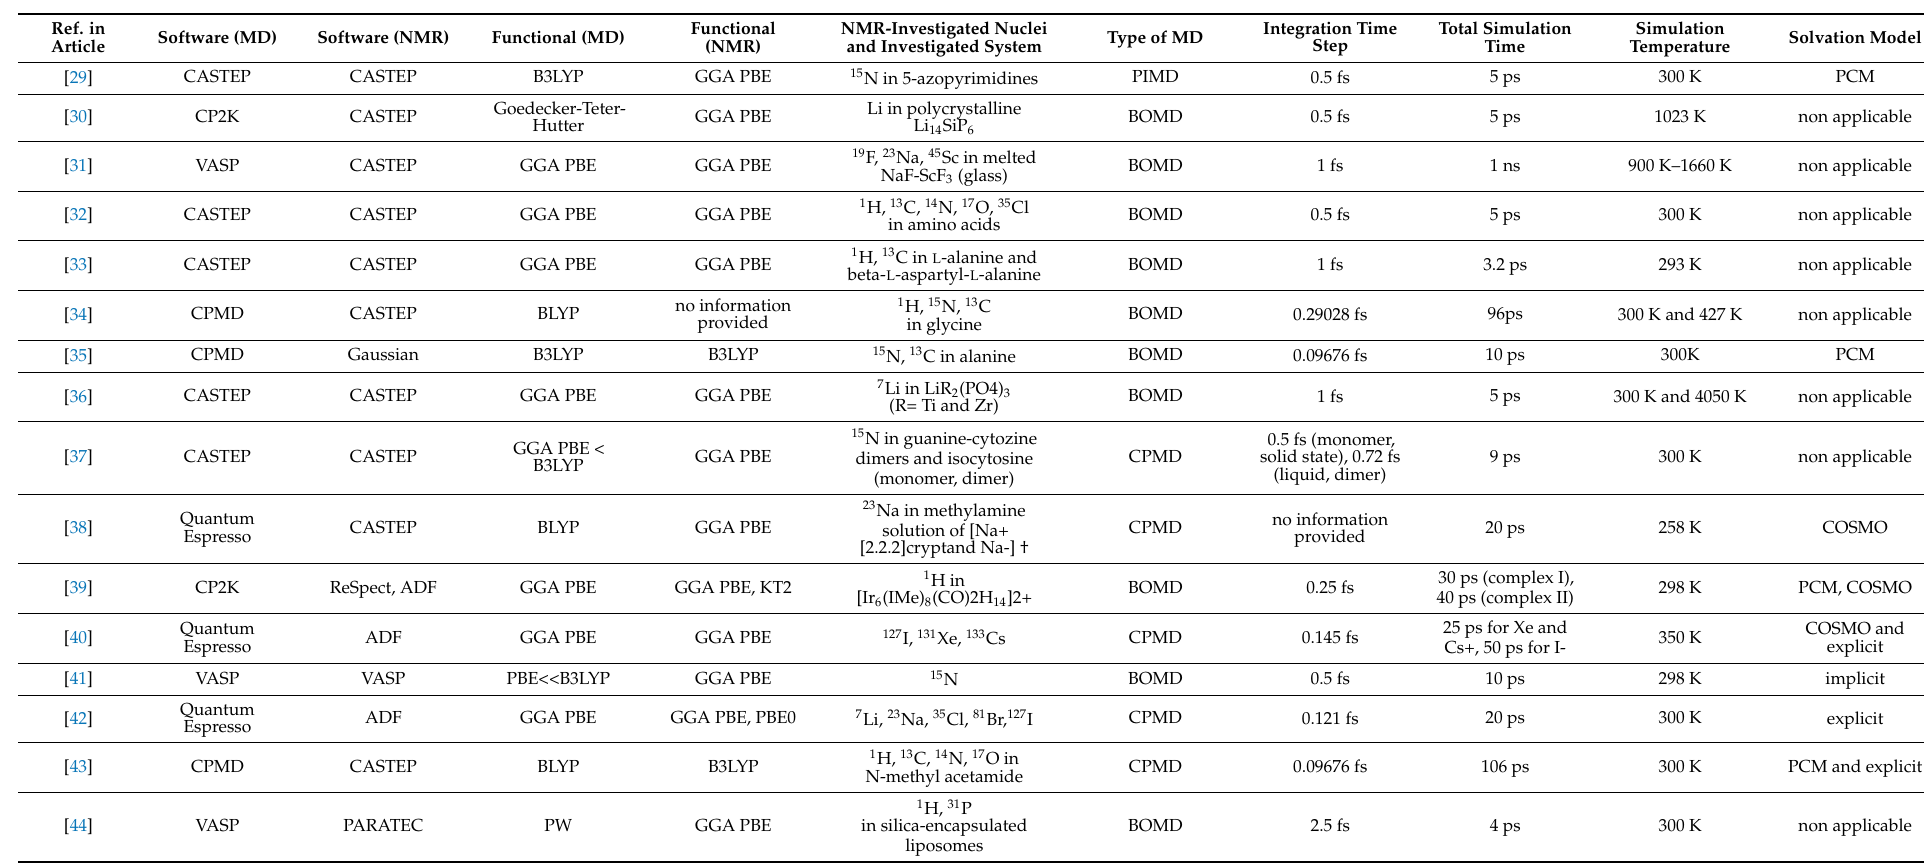
Table 1. Computational details of literature examples of aiMD combined with DFT-NMR calculations studies. The systems analyzed in a solid state are bolded. Ref. in